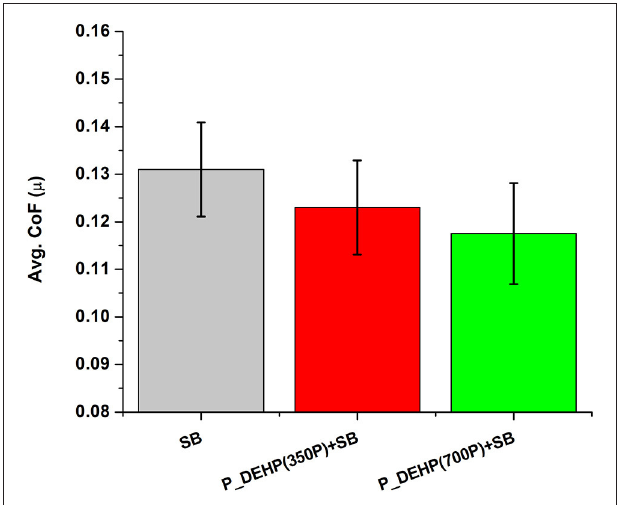
FIGURE 4 | Wear volume obtained for oil formulations containing only SB, P_DEHP(350P) + SB and P_DEHP(700P) + SB for a 60min test.